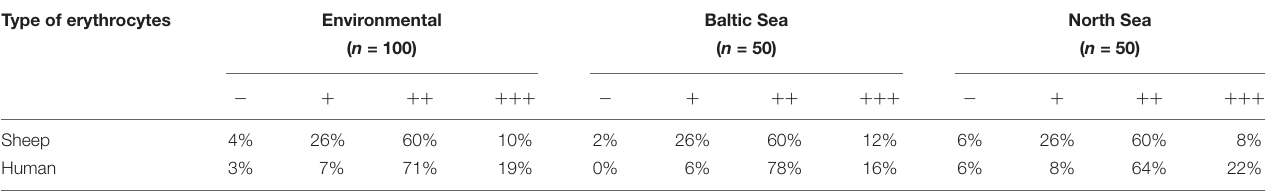
TABLE 4 | Hemolytic activity of Vibrio cholerae non-O1, non-O139 isolates from German coastal waters analyzed in this